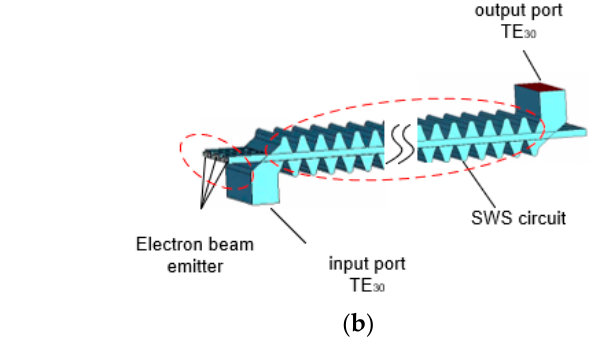
Figure 10. Vacuum model for PIC simulation calculation. ( a ) Single-beam SWG TWT. ( b ) Multi-beam overmoded SWG TWT.